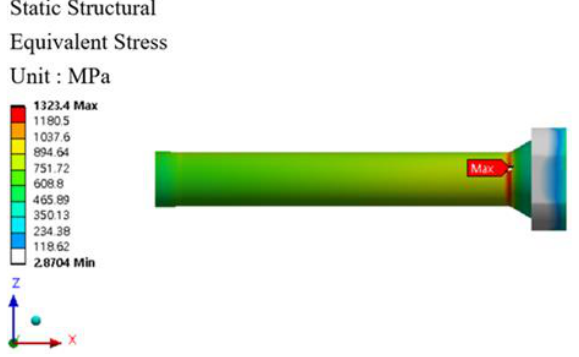
Figure 30. Results of the fatigue analysis of stem at 400 °C.